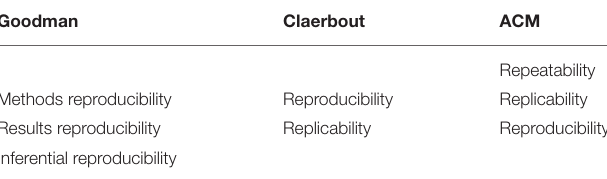
TABLE 1 | Comparison of terminologies. See text for